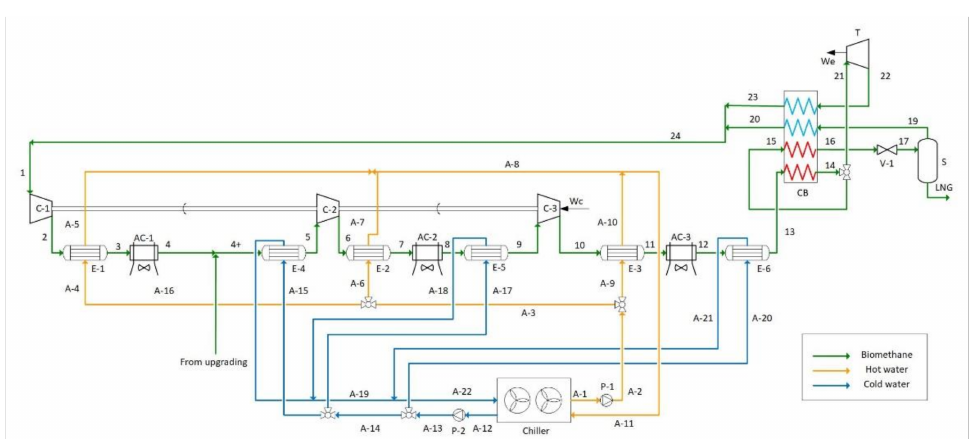
Figure 5. Absorption chiller set-up 2 (AC-2).